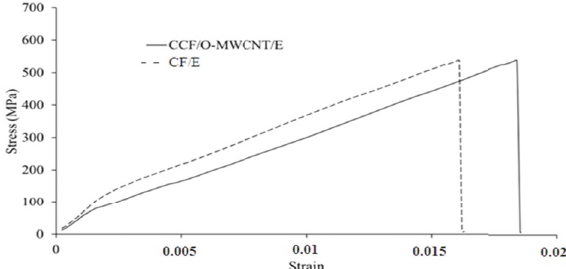
Figure 3: Stress strain behavior of CF/E and CCF/O-MWCNT/E